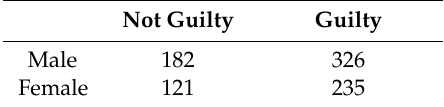
Table 1. Number of not guilty and guilty verdicts across participant sex. Not Guilty